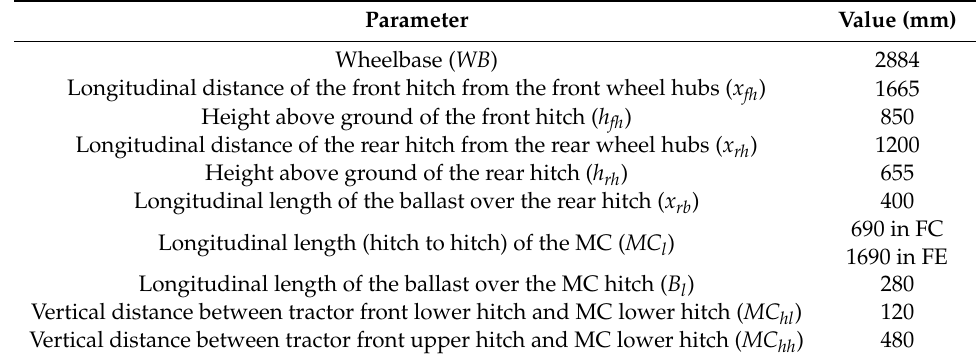
Table A1. Dimensions for FC, FE and R configurations.